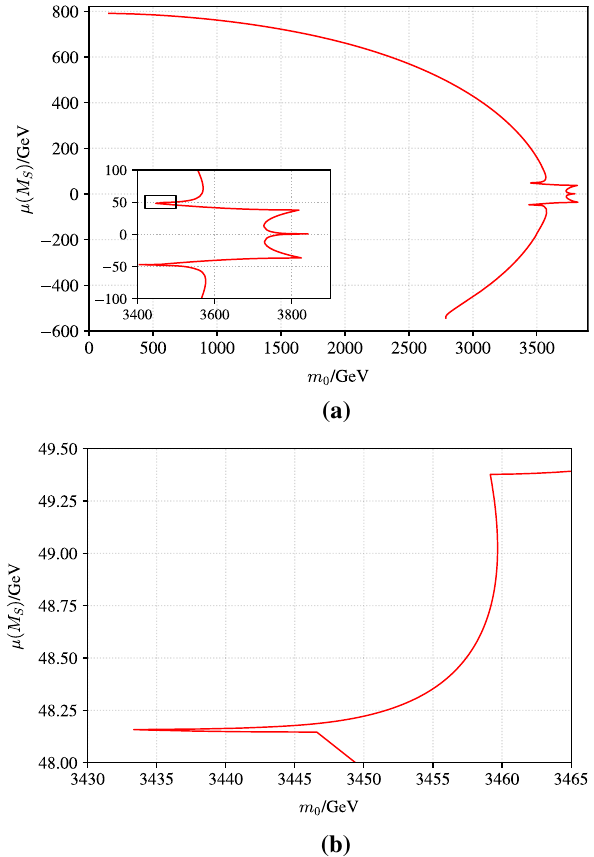
Fig. 5 A scan over μ with output m 0 for the low-energy input param- eters { M Z , M W } and the CMSSM parameters given in Eq.(9). In order to make all kinks visible, the boxed region in ( a ) is enlarged and shown in ( b )